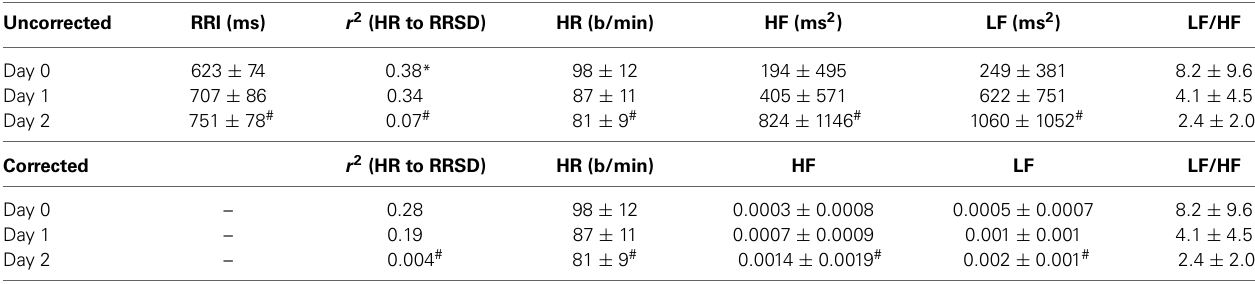
Table 1 | Heart rate variability indices with and without correction for prevailing HR. Uncorrected